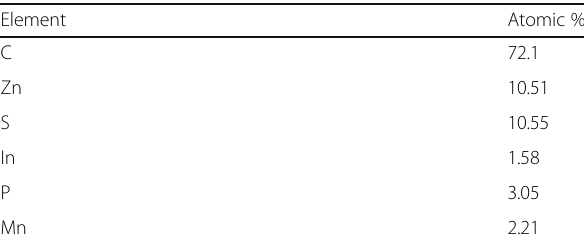
Table 1 The detailed element content of Mn:InP/ZnS QDs (Mn/ In =